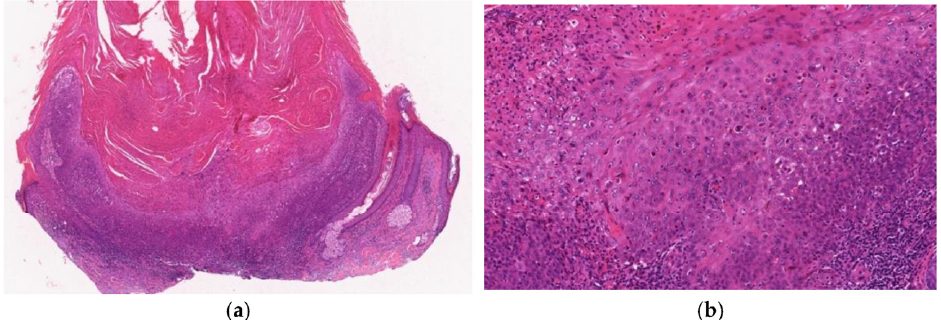
Figure 10. Histopathological findings of crateriform Bowen disease. The lesion shows crateriform and exo-endophytic proliferation with a central keratotic plug and overhanging epithelial lip-like structures ( a ). Typical features of Bowen’s disease, which are full-thickness dysplasia with markedly atypical keratinocytes, are seen in the epidermis ( b